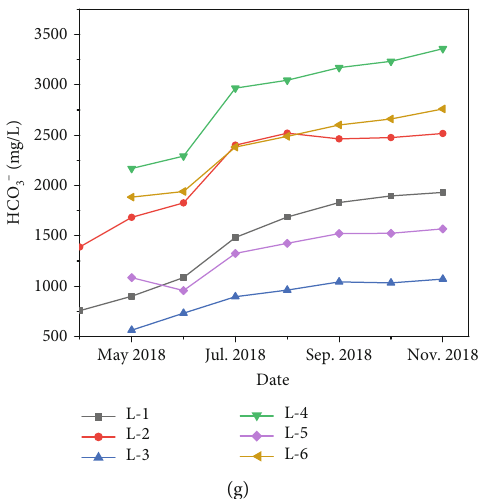
Figure 2: Ion concentration changes with time.